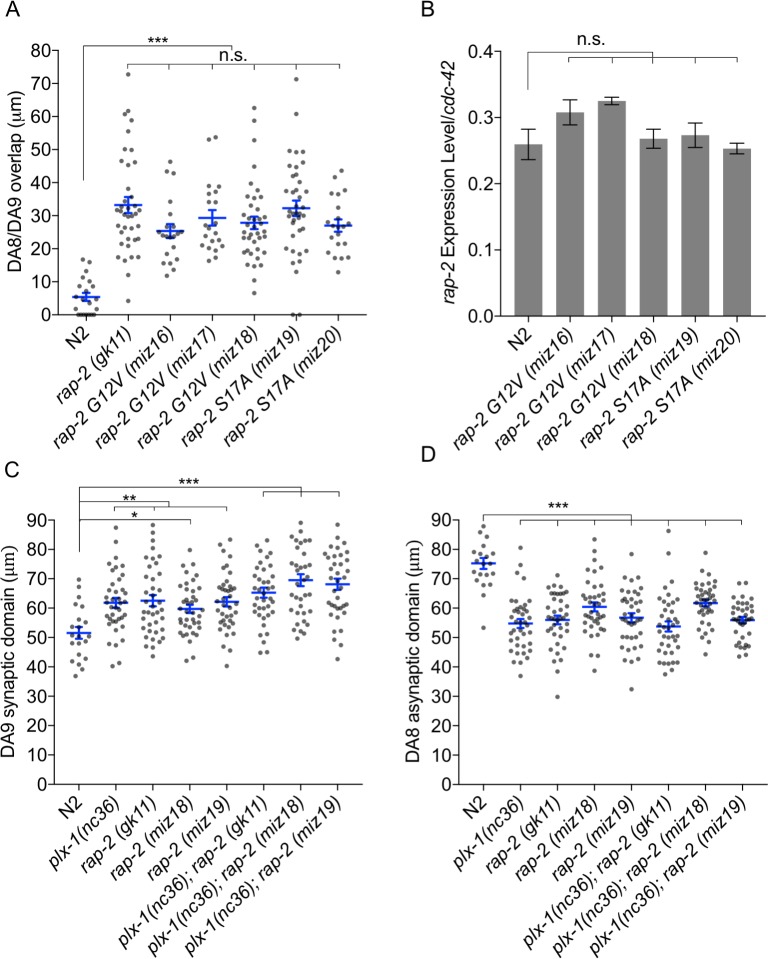
Synaptic tiling requires both GTP- and GDP-bound forms of RAP-2.(A) Quantification of DA8/DA9 overlap. Blue bars indicate mean ± SEM. n.s.: not significant; **p<0.001. (B) RT-qPCR analysis of rap-2 CRISPR mutants. cdc-42 served as an internal reference. Average of 3 independent qPCR reactions are shown. Bars indicate mean ± SEM. n.s.: not significant. (C) Quantification of DA9 synaptic domain length. (D) Quantification of DA8 asynaptic domain length. Blue bars indicate mean ± SEM. n.s.: not significant; ***p<0.001; **p<0.01, *p<0.05.